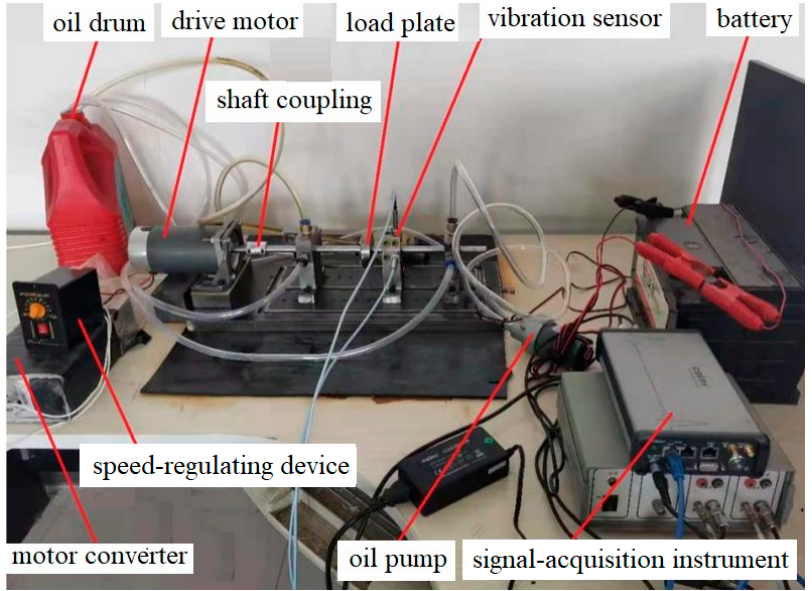
Figure 10. Test diagram of the floating ring rotor test device.